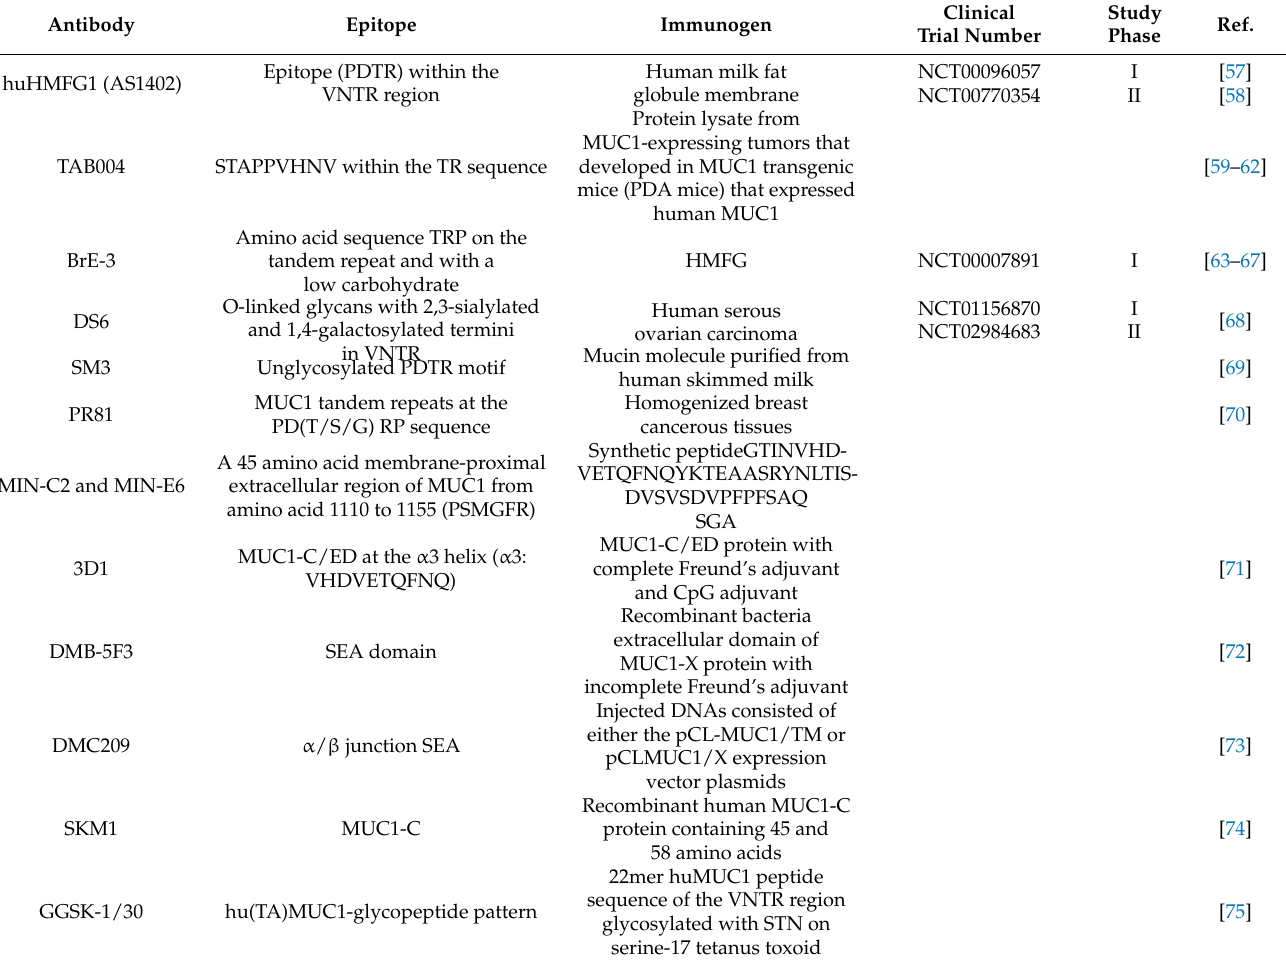
Table 1. Anti-MUC1 antibodies and antibody-based clinical trials (in